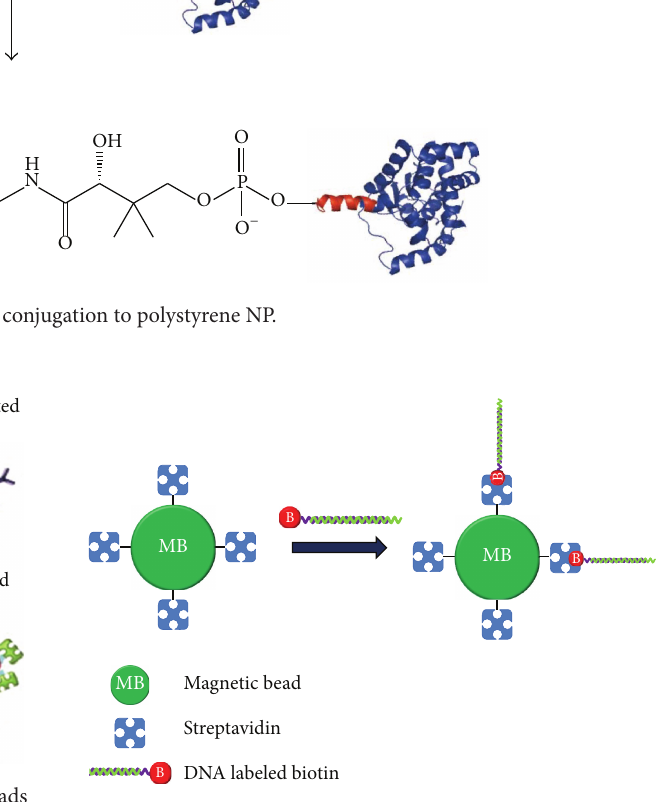
Figure 13: DNA attachment to the magnetic